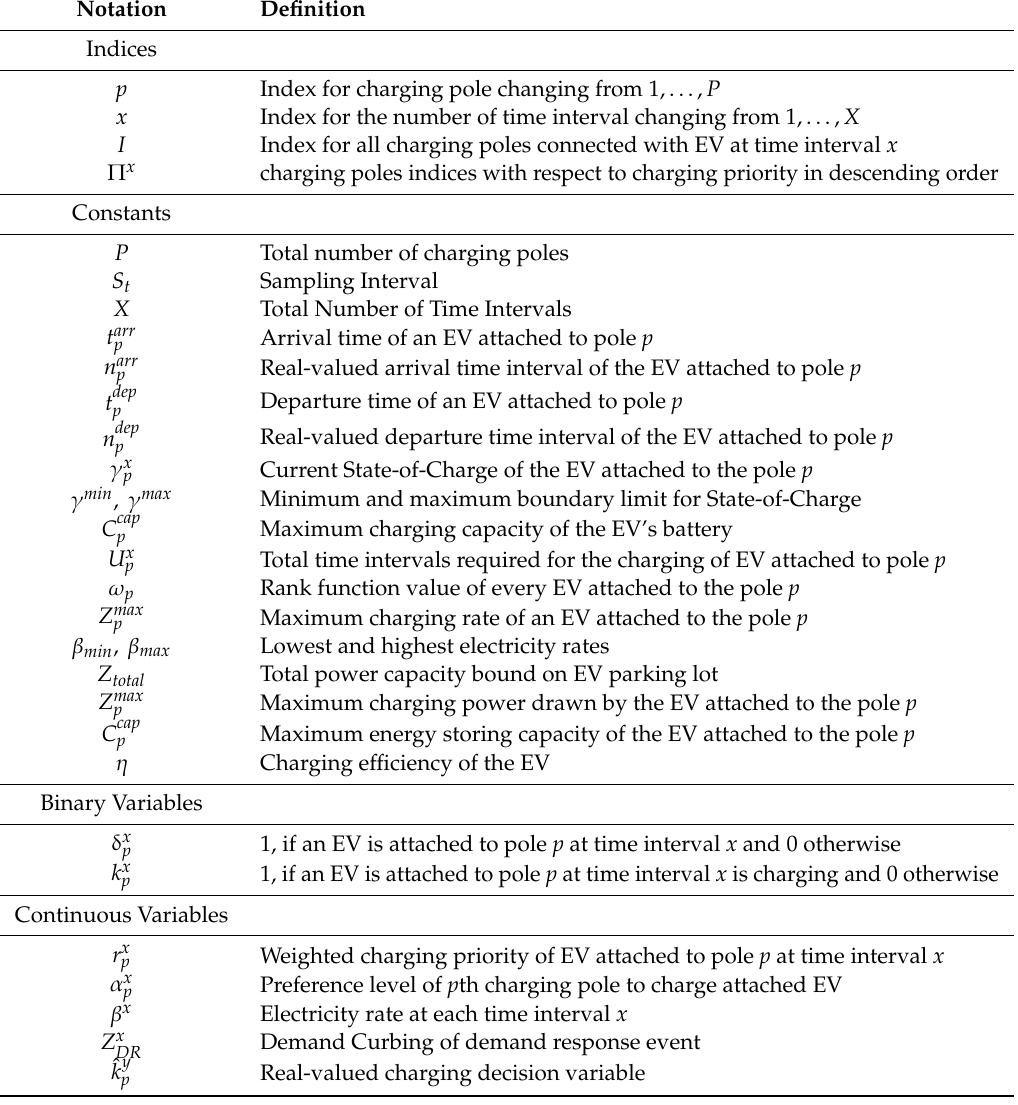
Table 1. Notations used in the System